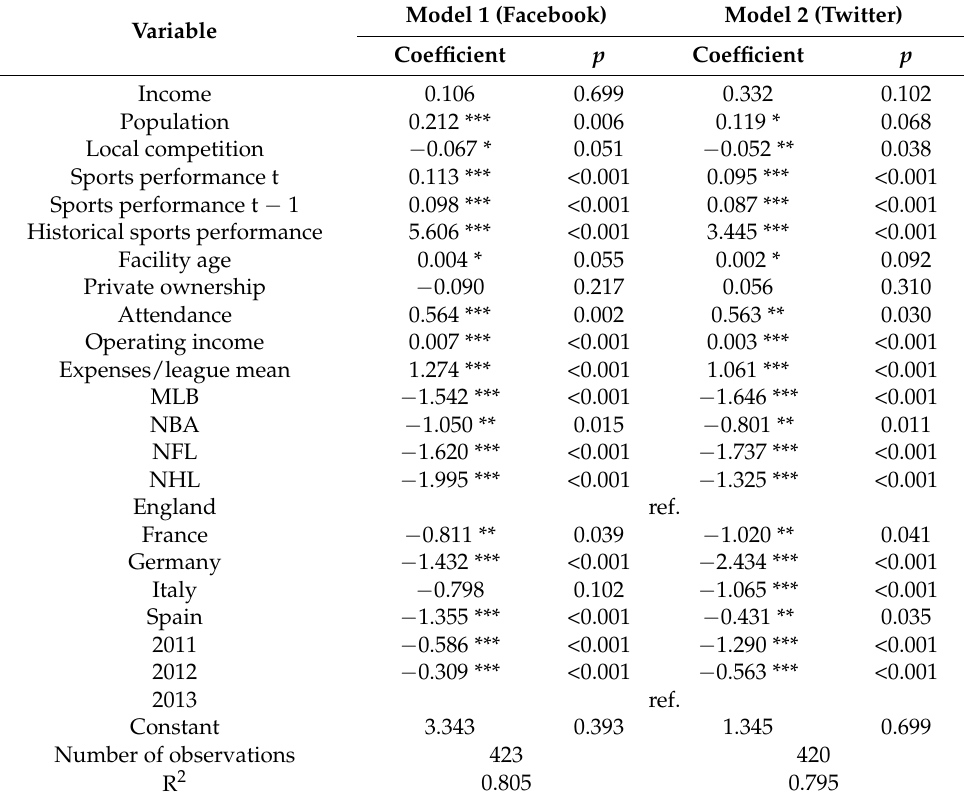
Table 2. Estimates of the log of the numbers of Facebook fans and Twitter